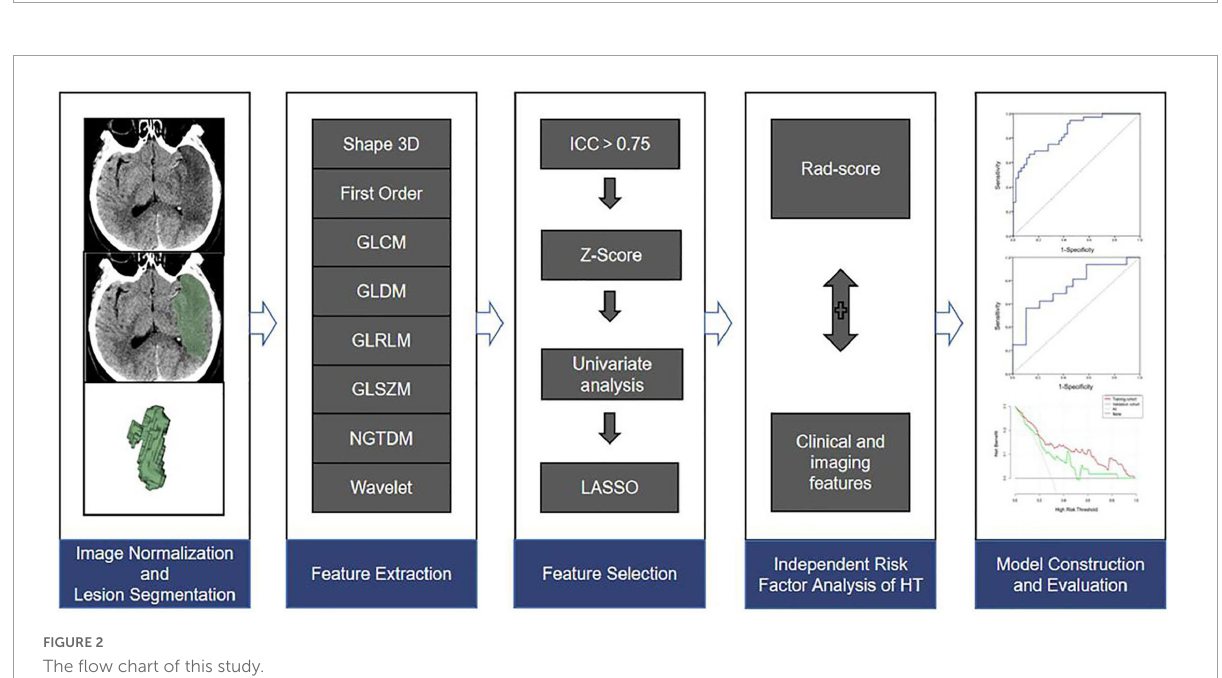
FIGURE2 The flow chart of this